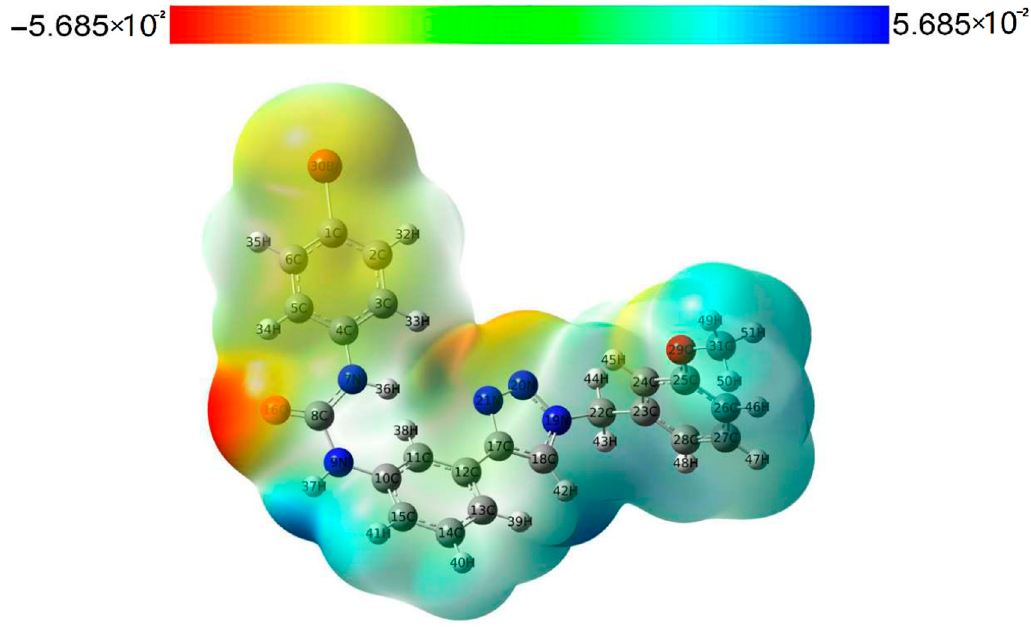
Figure 6. MEP surfaces of compound 3a.